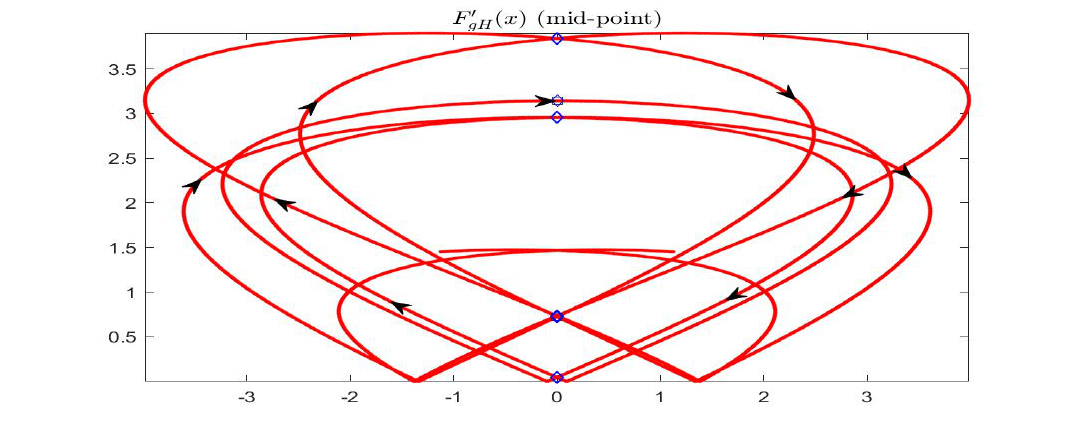
(cid:12) (cid:12) (cid:16) (cid:12)(cid:17) (cid:48) ( x ) (cid:12) (cid:12) ( x ) = in midpoint (cid:98) f (cid:48) ( x ) ; (cid:12) (cid:101) f gH